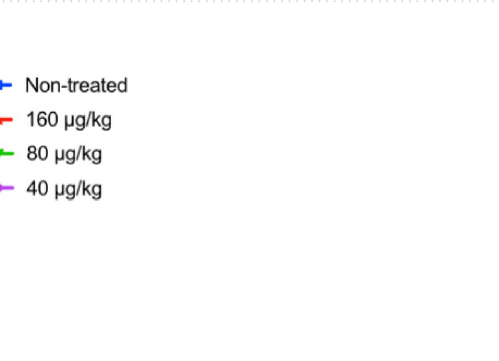
Figure 4. SBPD-1 selectively inhibited PSMA-expressing tumor growth in vivo. ( a ) Changes in size of PSMA + PC3 PIP and PSMA − PC3 flu subcutaneous tumors grown in NSG mice treated with varying doses of SBPD-1. ( b ) A fourfold increase in tumor volume was scored as death of an animal.